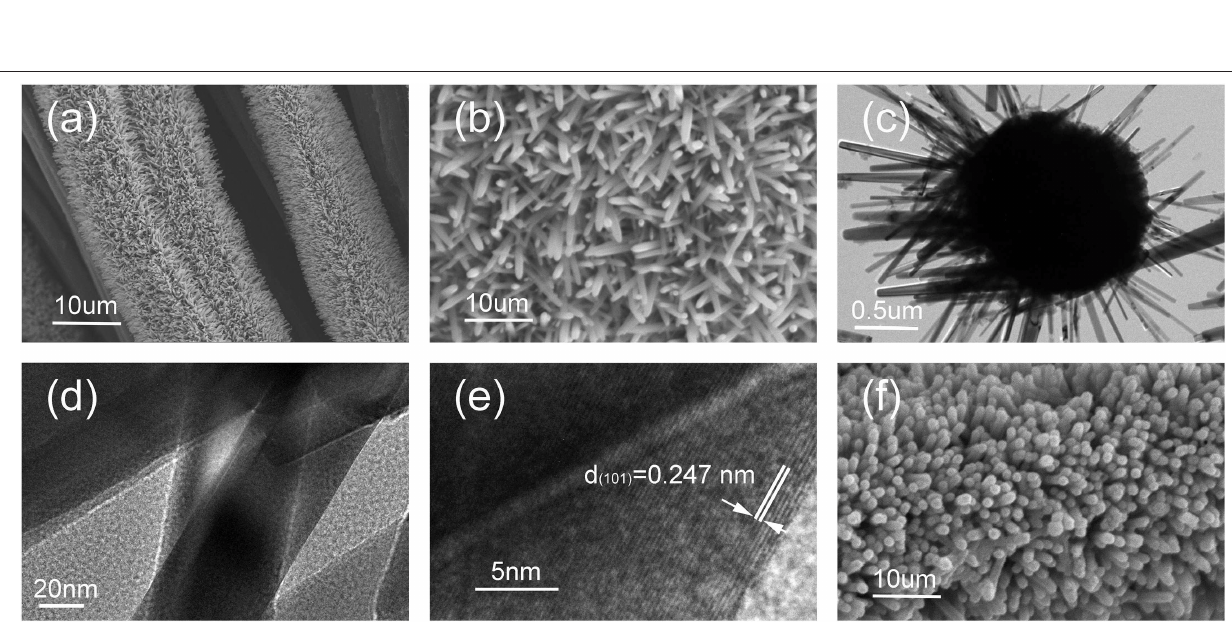
Frontiers in Materials |